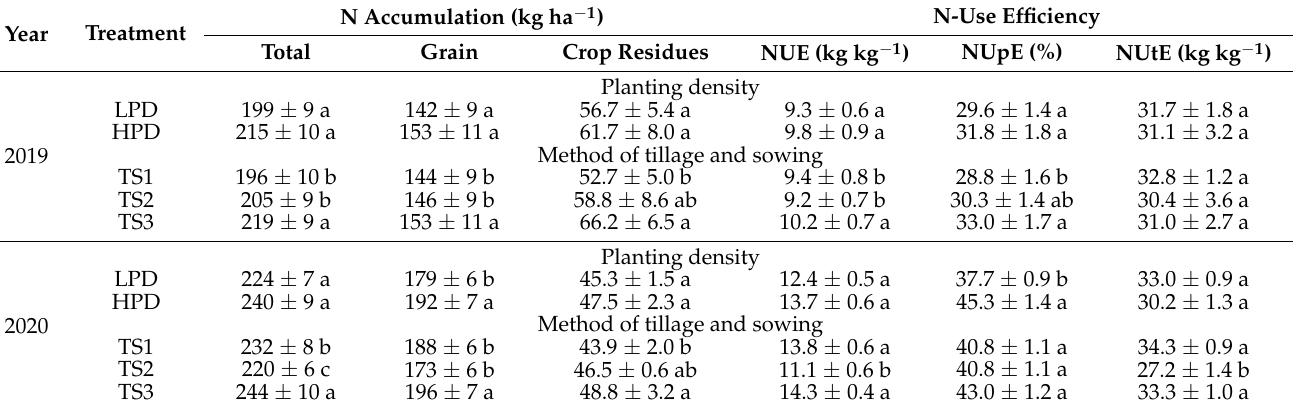
Table 4. Effects of planting density and method of tillage and sowing on N accumulation and N-use efficiency in 2019 and